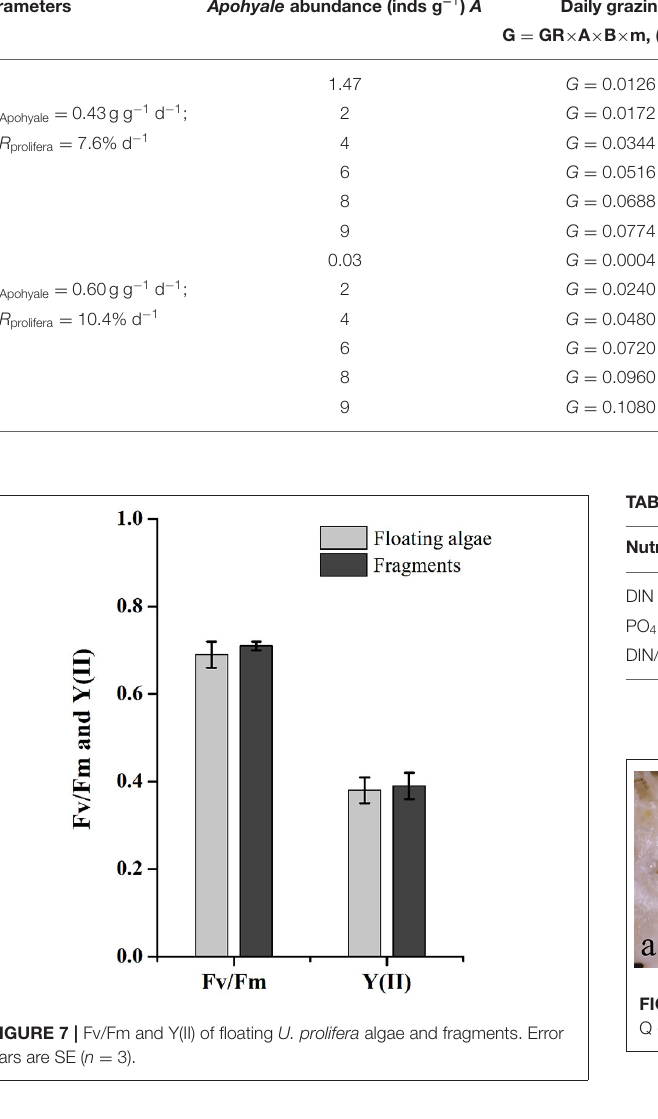
to Qingdao coast. This demonstrates that macrobenthos